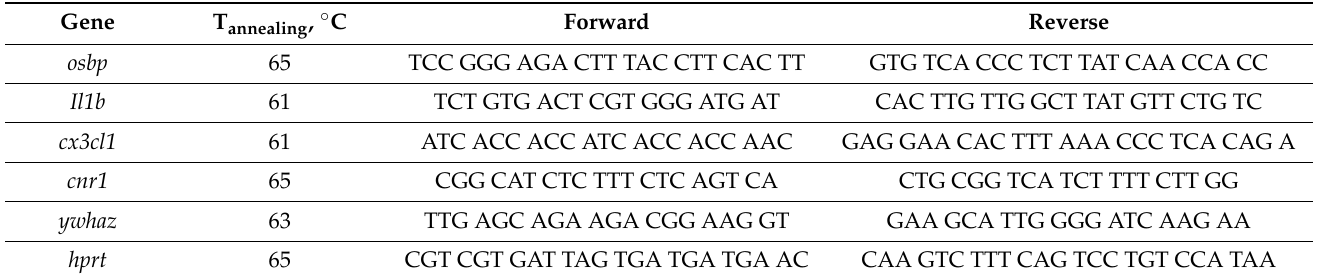
Table 1. Sequences of primers and annealing temperatures used for each primer pair (5 (cid:48) > 3 (cid:48)